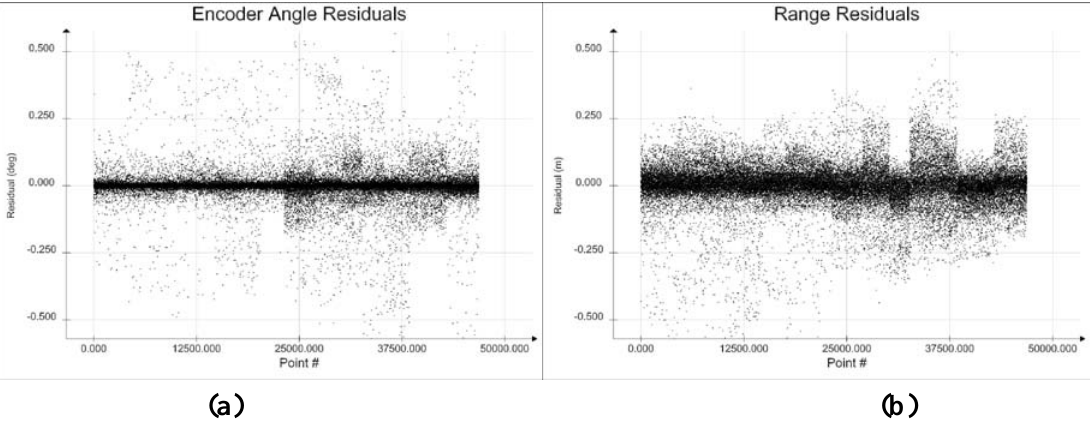
Figure 5. (a) Encoder Angle Residuals. (b) Range Residuals for Least Squares